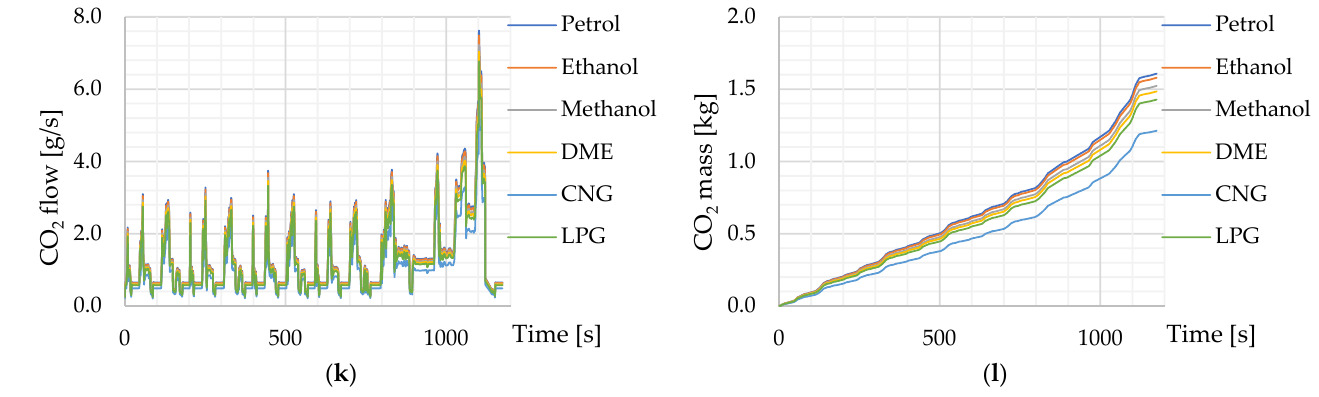
Figure 12. 2018 Toyota Camry LE—waveforms of instantaneous values: ( a ) vehicle engine carbon dioxide emission stream obtained from UDDS road test simulation for selected fuels; ( b ) vehicle engine carbon dioxide emission stream obtained from UDDS road test simulation for selected fuels; ( c ) vehicle engine carbon dioxide emission stream obtained from HWFET road test simulation for selected fuels; ( d ) vehicle engine carbon dioxide emissions obtained from HWFET road test simulation for selected fuels; ( e ) vehicle engine carbon dioxide emissions obtained from US06 road test simulation for selected fuels; ( f ) vehicle engine carbon dioxide emissions obtained from US06 road test simulation for selected fuels; ( g ) vehicle engine carbon dioxide emissions obtained from LA92 road test simulation for selected fuels; ( h ) vehicle engine carbon dioxide emissions obtained from LA92 road test simulation for selected fuels; ( i ) vehicle engine carbon dioxide emissions obtained from WLTC road test simulation for selected fuels; ( j ) vehicle engine carbon dioxide emissions obtained from WLTC road test simulation for selected fuels; ( k ) vehicle engine carbon dioxide emissions obtained from NEDC road test simulation for selected fuels; ( l ) vehicle engine carbon dioxide emissions obtained from NEDC road test simulation for selected fuels. Table 9. Summary of the final CO 2 emissions obtained from the 2018 Toyota Camry LE vehicle simulation for selected road tests.